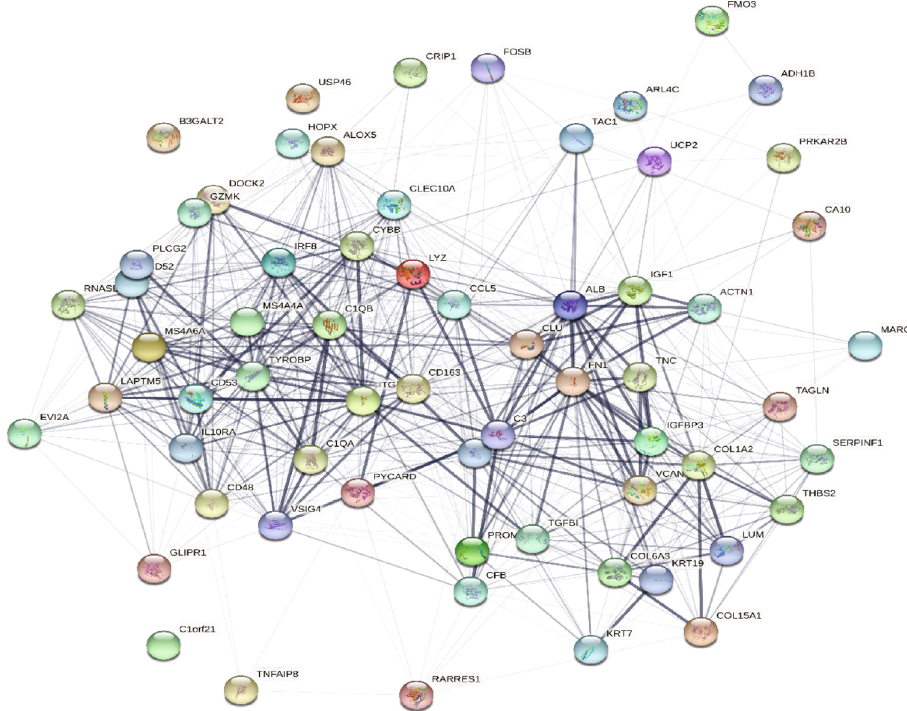
Figure 3: The PPI network of overlapping DEGs of three microarray datasets. Each circular node represents a protein target, and the 3D structure in the circular nodes shows the protein spatial structure. The lines among di ff erent nodes represent the association among potential protein targets, while the width of lines was according to the action intensity.